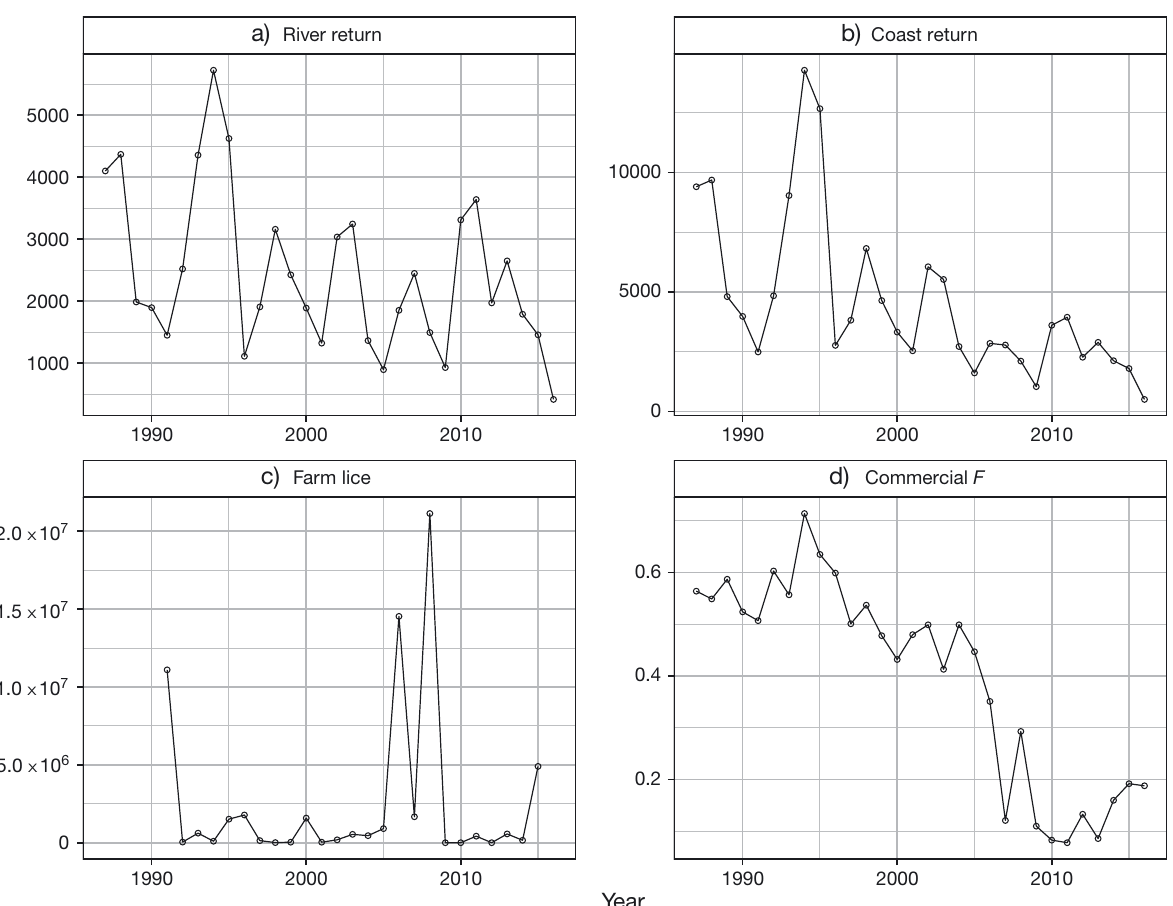
Fig. 3. Time series of returns of 1 sea-winter (1SW) Erriff River Atlantic salmon (a) to the river ( S iRiver ) and (b) to the Irish coast ( S iCoast ); (c) estimated number of sea lice in the Killary salmon farm; and (d) estimated commercial fishing mortality ( F) for Erriff